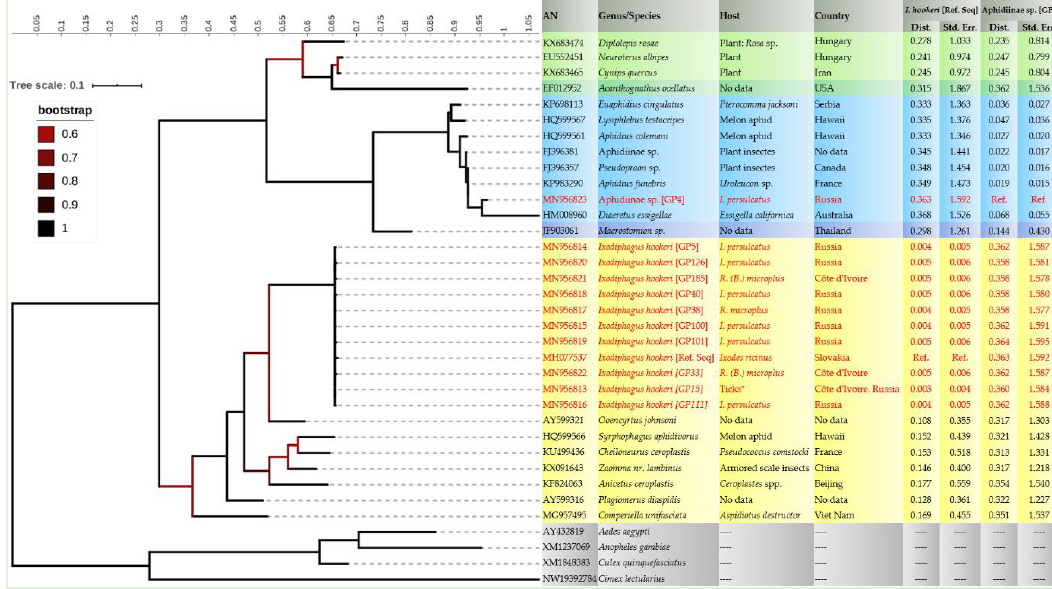
Figure 4. Phylogenetic tree showing the position of I. hookeri and Aphidiinae sp. GP4 genotypes obtained in the present study (indicated in red) among the representative members of hymenopteran parasitoids families. The tree was inferred using the Maximum Likelihood method based on 1000 bootstraps and the Kimura 2-parameter model [38]. The analysis involved 35 partial 28S DNA sequences. There were a total of 646 positions in the final dataset. Outgroup taxons Culicidae (AY432819, XM1237069 and XM1848383) and Cimicidae (NW19392784) are drawn at root. The highest log likelihood was −7750.7467. The axis showed the global distance observed throughout the trees. Branches are color-coded according to the bootstrap’s percent. The identity of each taxa is color-coded according to the family/subfamily (pistachio green: Cynipidae/Cynipinae; green: Formicidae/Myrmicinae; light blue: Braconidae/Aphidiinae; yellow: Encyrtidae/Encyrtinae; grey: outgroup taxons). GenBank accession numbers, species, hosts and geographical origin when available are indicated at each node. The number of base substitutions and the Standard error estimate(s) per site from between the reference sequences of I. hookeri and Aphidiinae sp. genotype GP4 and hymenopteran parasitoids from GenBank are shown. Analyses were conducted using the Maximum Composite Likelihood model [39]. All ambiguous positions were removed for each sequence pair (pairwise deletion option).